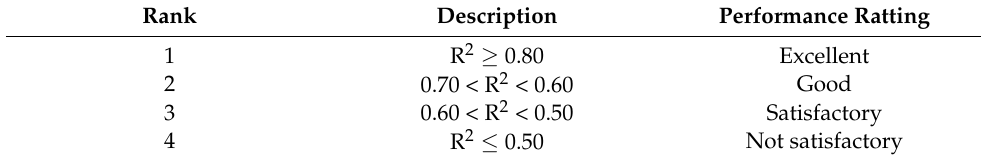
Table 2. The statistical performance evaluation for determining goodness of fit.